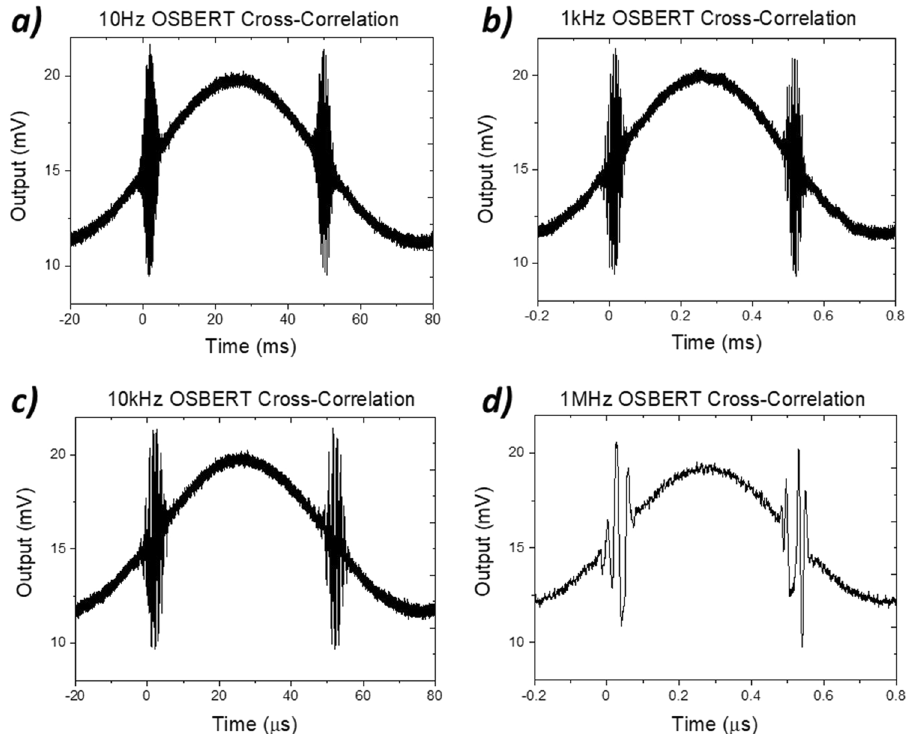
Figure 3. Live oscilloscope traces showing 10 Hz, 1 kHz, 10 kHz and 1 MHz OSBERT cross-correlation traces featured over a real time duration of 100 ms, 1 ms, 100 µs and 1 µs